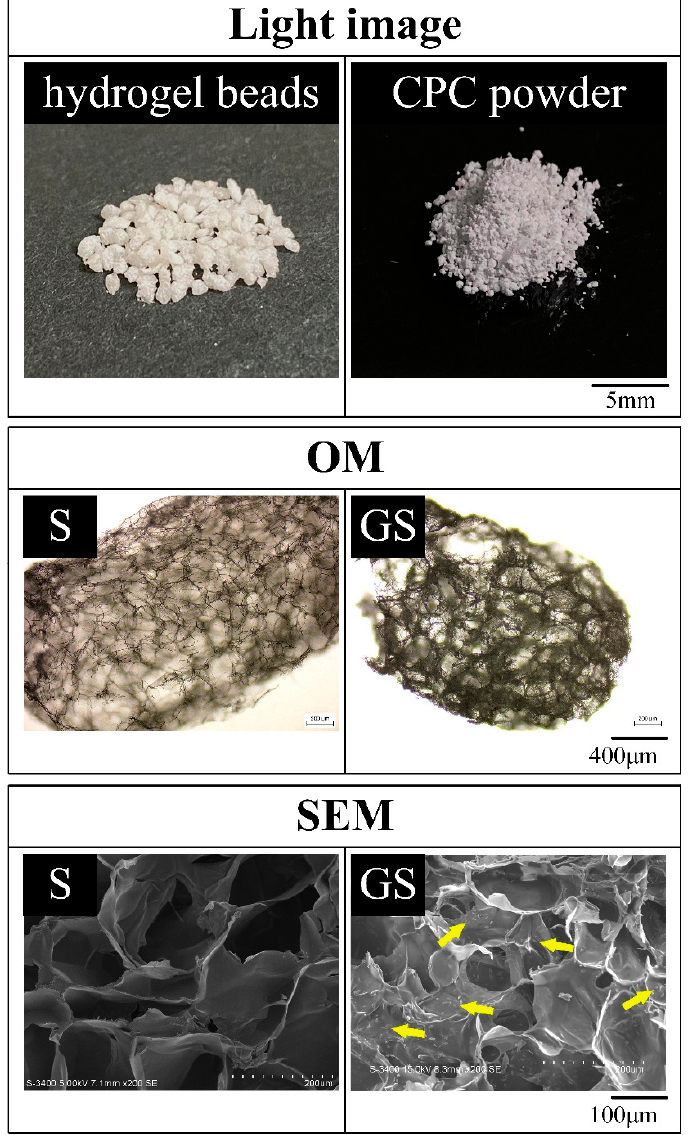
Figure 1. Appearance and microscopic images of hydrogel spherical beads before and after gentamicin impregnation (S: hydrogel-only, GS: gentamicin-impregnated hydrogel; yellow arrow shows the gentamicin dispersion; OM: optical images produced in the microscope; SEM: images produced by scanning electron microscope).